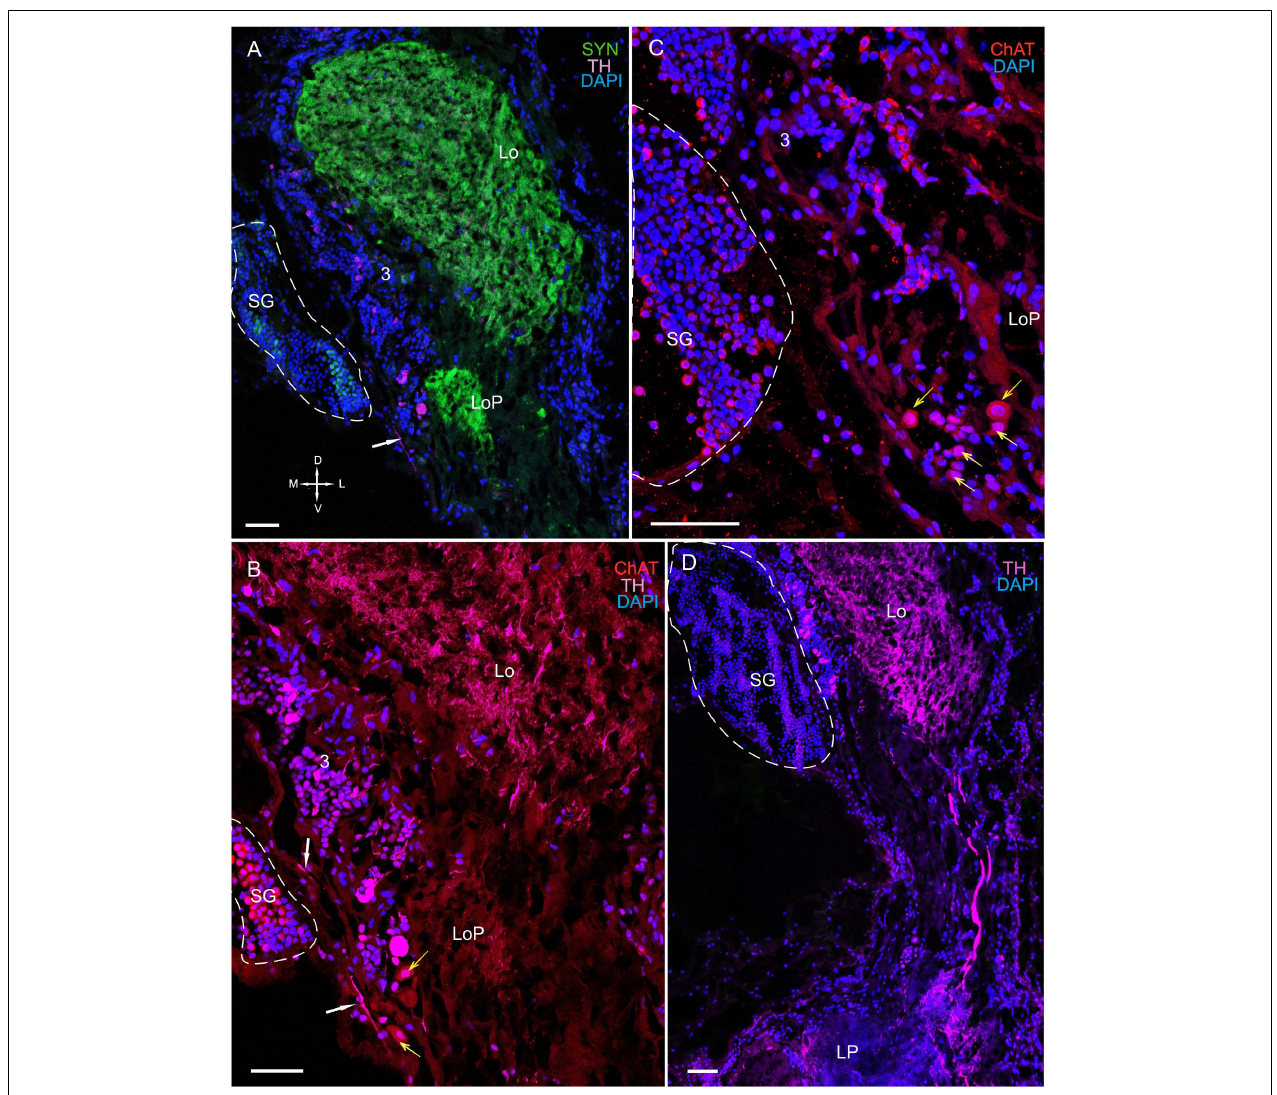
FIGURE 8 | Immunolocalization of TH, ChAT, and SYN in the lobula, lobula plate, and SG. (A) Photographs demonstrating the position of TH-positive cell bodies near the Lo and LoP. (B) TH- and ChAT-positive immunostaining in the SG (yellow arrows: ChAT-positive somata). TH-positive fibers running between neurons of cluster 3 and the SG (white arrows). (C) ChAT-positive neurons localized near the front edge of the Lo and near the LoP. (D) TH-positive nerve fibers connect the Lo and LP. Green, SYN; magenta, TH; red, ChAT; blue, DAPI. Dashed lines indicate cells of the SG. Scale bars = 100 µ m. Lo, lobula; LoP, lobula plate; LP, lateral protocerebrum; SYN, synapsin; D, dorsal; V, ventral; L, lateral; M, medial; A, anterior; P,